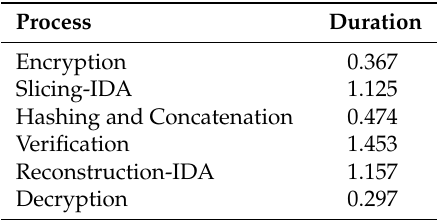
Table 4. Average encoding/decoding